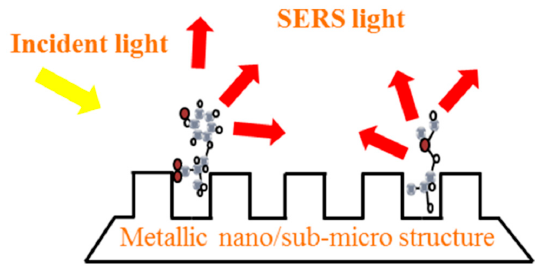
Figure 2. The schematic diagram of the enhancement of the Raman scattering light on the metallic nano/sub-microstructure